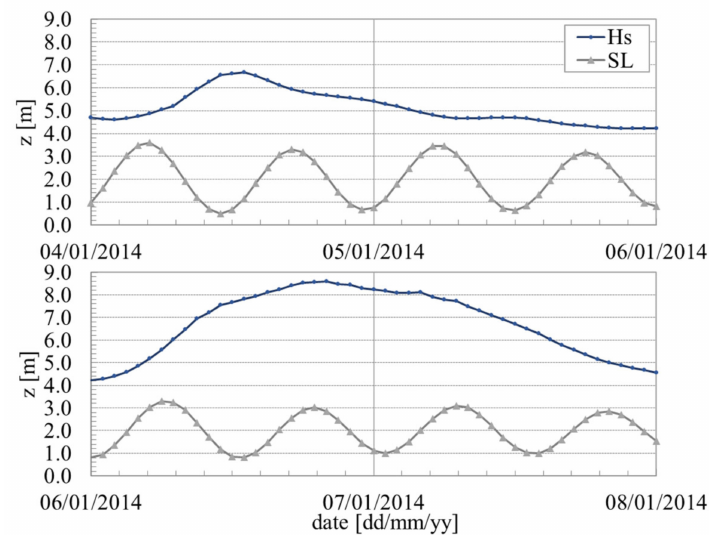
Figure 6. Significant wave height and sea level time series of the Hercules storm, from 4 January 2014 00h00 to 8 January 2014